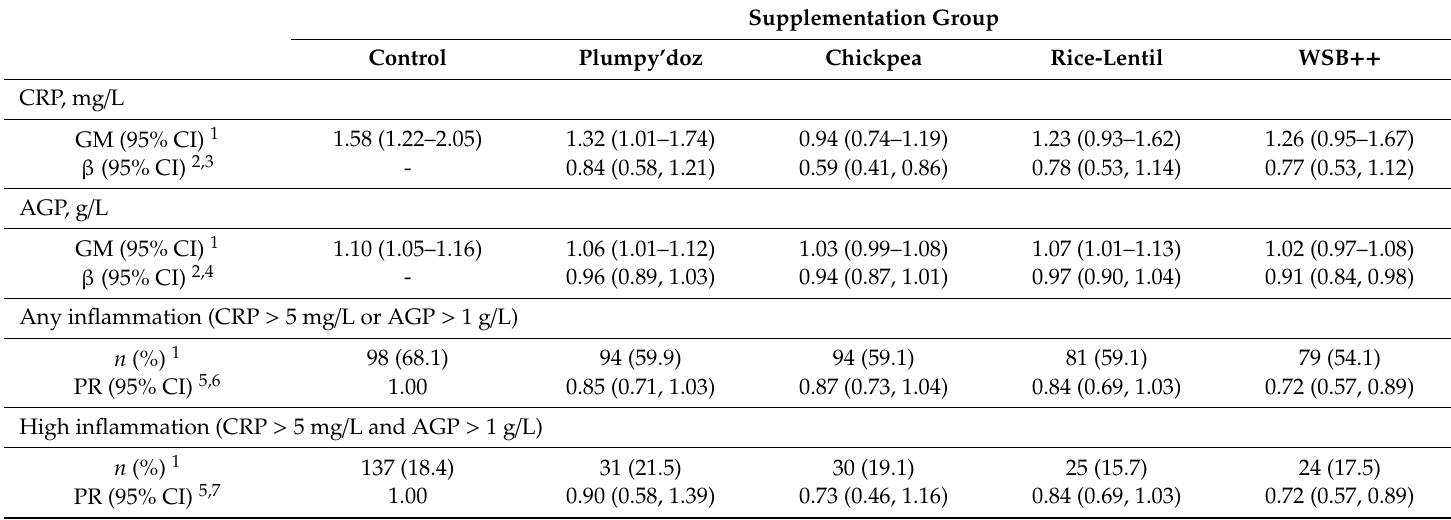
Table 3. Inflammation biomarkers, the prevalence of inflammation and modeled di ff erences, and prevalence ratios by supplementation group at age 18 months following one year of participation in a complementary food supplementation trial in rural